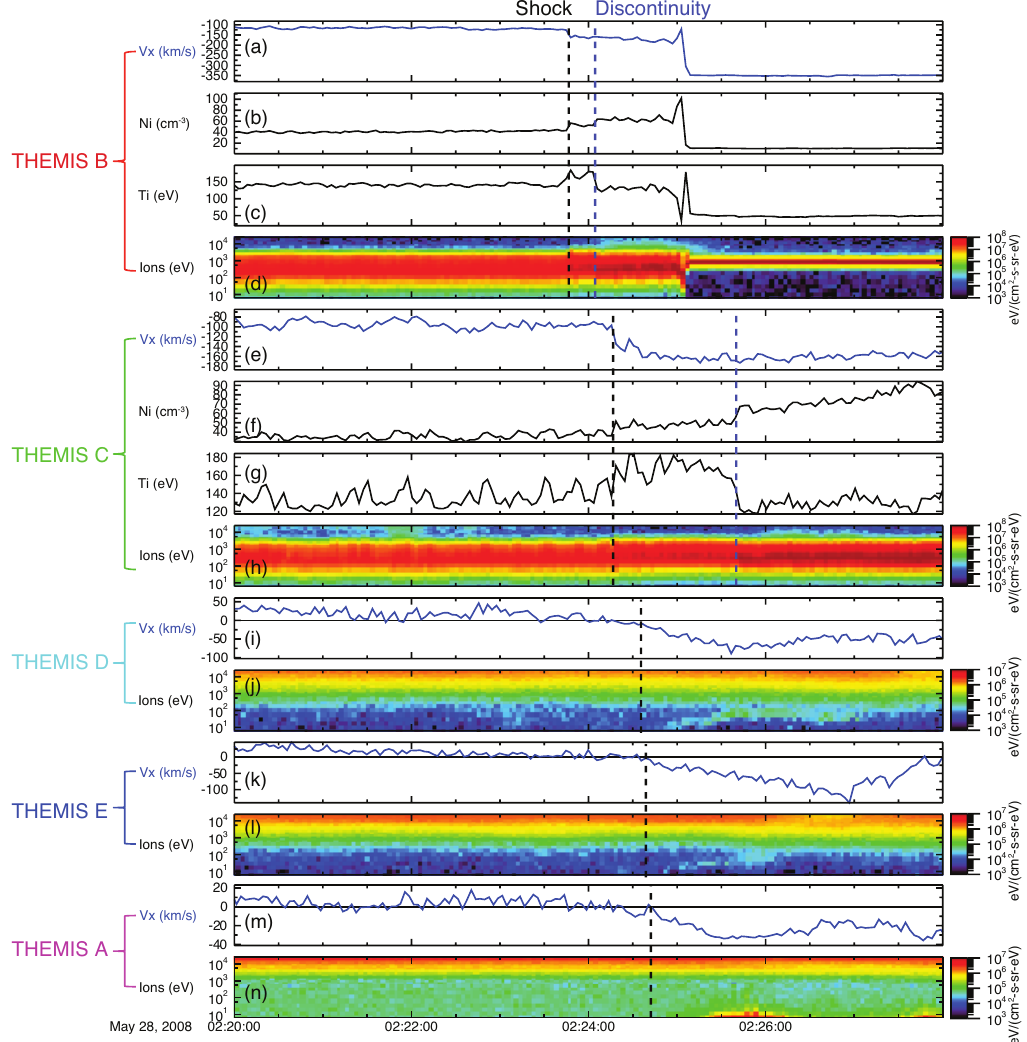
Fig. 3. The propagation of the IP shock through the magnetosheath and in the magnetosphere. From top to bottom: (a) – (d) THEMIS B ESA plasma flow V x component, ion density, temperature, spectrum, (e) – (h) THEMIS C ESA plasma flow V x component, ion density, temperature, spectrum, (i) and (j) THEMIS D ESA plasma flow V x component, ion spectrum, (k) and (l) THEMIS E ESA plasma flow V x component, ion spectrum, (m) and (n) THEMIS A ESA plasma flow V x component, ion spectrum. The bow shock crossing was observed by THEMIS B near 02:25UT. The vertical black dashed lines mark the transmitted shock (top 8 panels) or the time when the plasma inside the magnetosphere started to move earthward (bottom 6 panels). The vertical blue dashed lines in the top 8 panels mark the discontinuity produced by the interaction of the IP shock and the bow